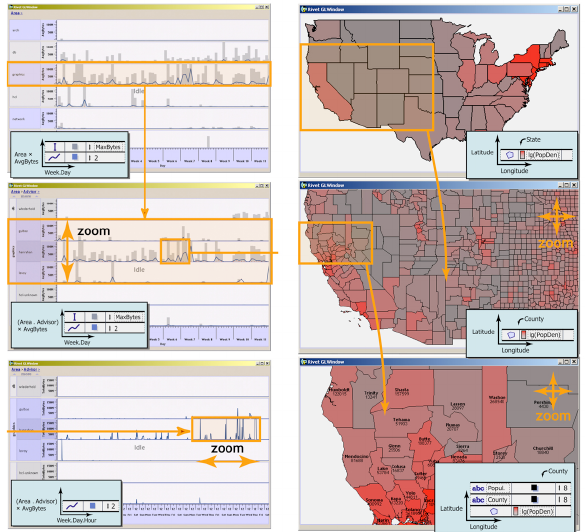
Figure 2. From left, the Zoom Graph for the Chart Stacks Pattern, A series of screenshots of a multiscale visualization of yeast microarray data (Stolte et al.)